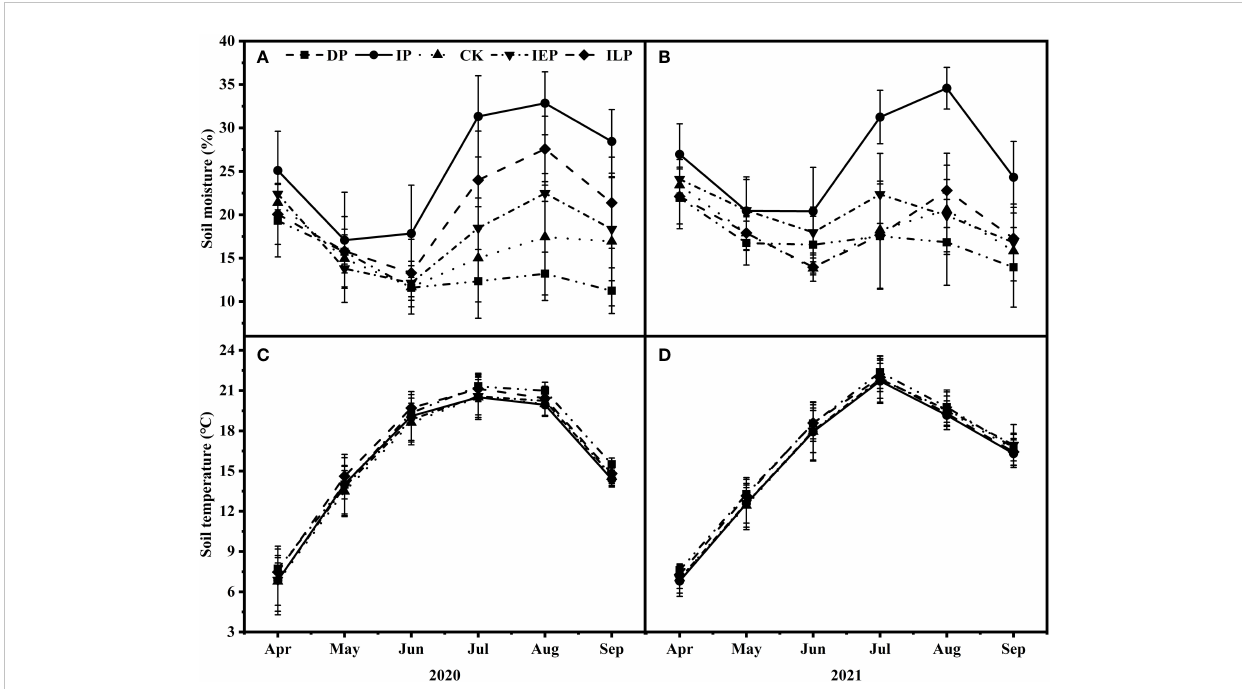
FIGURE 1 Effects of intra-annual precipitation patterns during the growing seasons (April – September) on (A, B) soil moisture and (C, D) soil temperature from 2020 to 2021 (means ± SE). Multi-year average precipitation during April – September in control (CK), 50% decrease in precipitation in entire growing season (DP, April – September), 50% increase in precipitation in entire growing season (IP, April – September), increase in the early growing season precipitation by 50% (IEP, April – June), and increase in the late growing season precipitation by 50% (ILP, July –